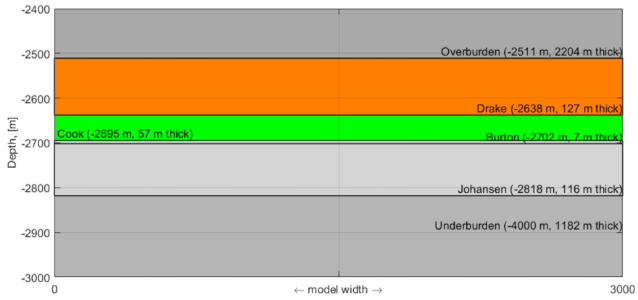
Figure 8. The various horizons specified in the numerical model. The depths are relative to mean sea level. The seafloor is at depth 307 m, which is the top boundary of the model, and the bottom boundary of the model is located at 4000 m. The width of the model is 6000 m. Cook Fm. (green) is the injection reservoir. The numbers indicate the bottom and the thickness of each